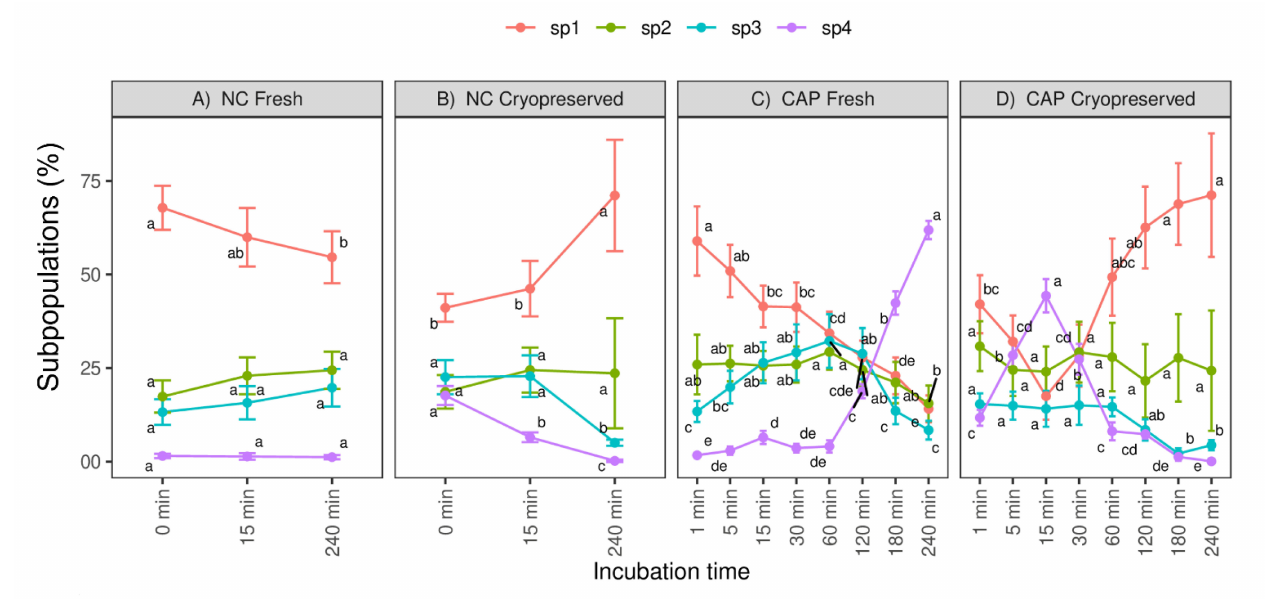
Figure 4. Distribution of fresh and frozen-thawed motile spermatozoa within subpopulations (SP1, SP2, SP3, SP4) over the incubation in capacitating (CAP) and non-capacitating (NC) media. ( A ) Motile subpopulations of fresh spermatozoa during NC conditions. ( B ) Motile subpopulations of frozen-thawed spermatozoa during NC conditions. ( C ) Motile subpopulations of fresh spermatozoa during CAP conditions. ( D ) Motile subpopulations of frozen-thawed spermatozoa during CAP conditions. SP1: progressive spermatozoa with low velocity; SP2: progressive spermatozoa with medium velocity and low oscillatory movement; SP3: fast and progressive spermatozoa with a high oscillatory movement; SP4: fast spermatozoa with the highest oscillatory movement and the lowest linearity (sperm with hyperactivated-like movement). Values are expressed as mean percentages ± S.E.M (n = 12 ejaculates, 4 rams × 3 replicates). Different letters denote substantial changes ( p < 0.05) among incubation times within each type of